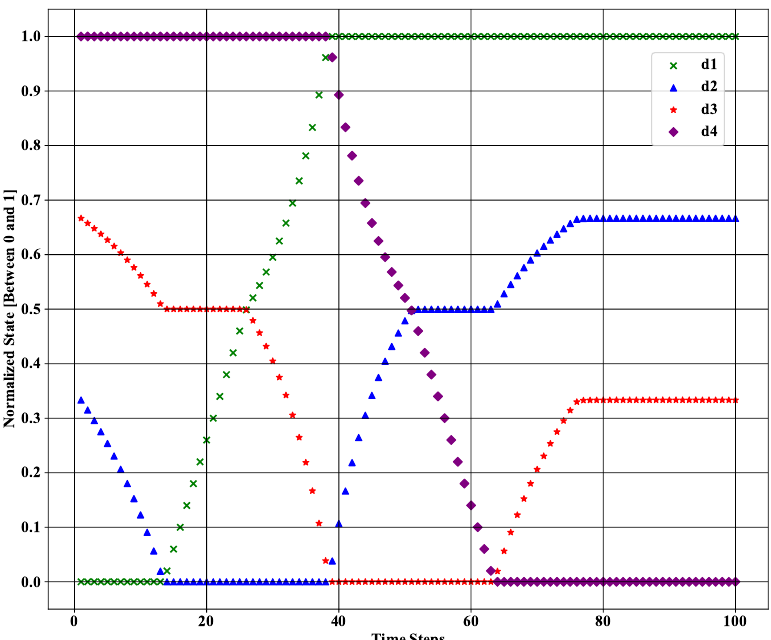
Figure 7. Normalized state value for each time step during the experiment.